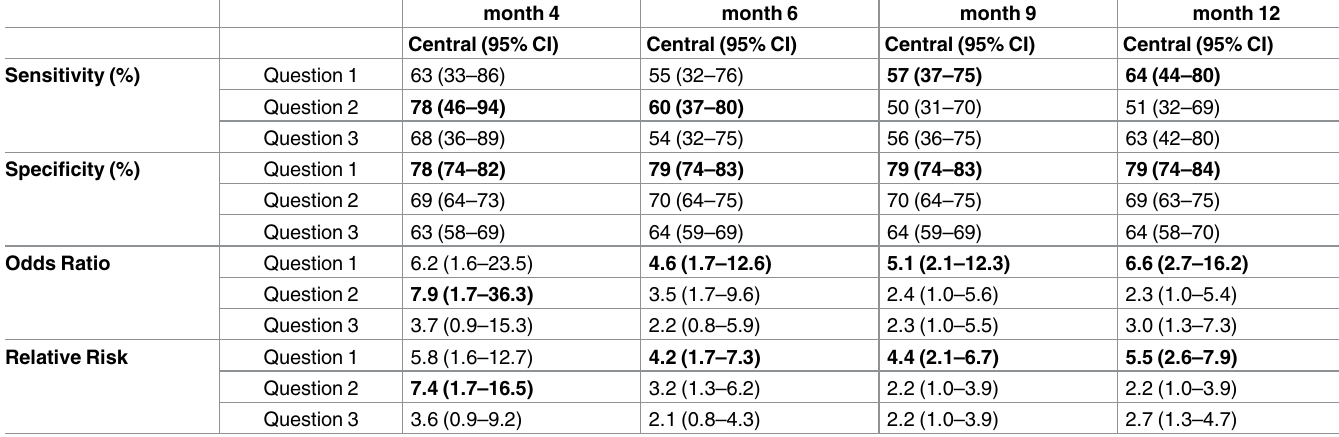
Table 3. Predictive validity of everyone of the questions in the study for the occurrence of repeated